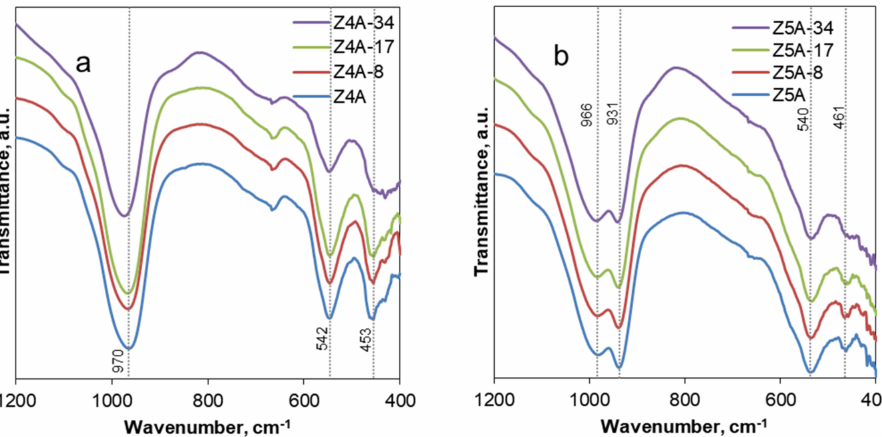
Figure 2. FTIR spectra of the parent and EDTA dealuminated zeolite 4A ( a ) and zeolite 5A ( b )